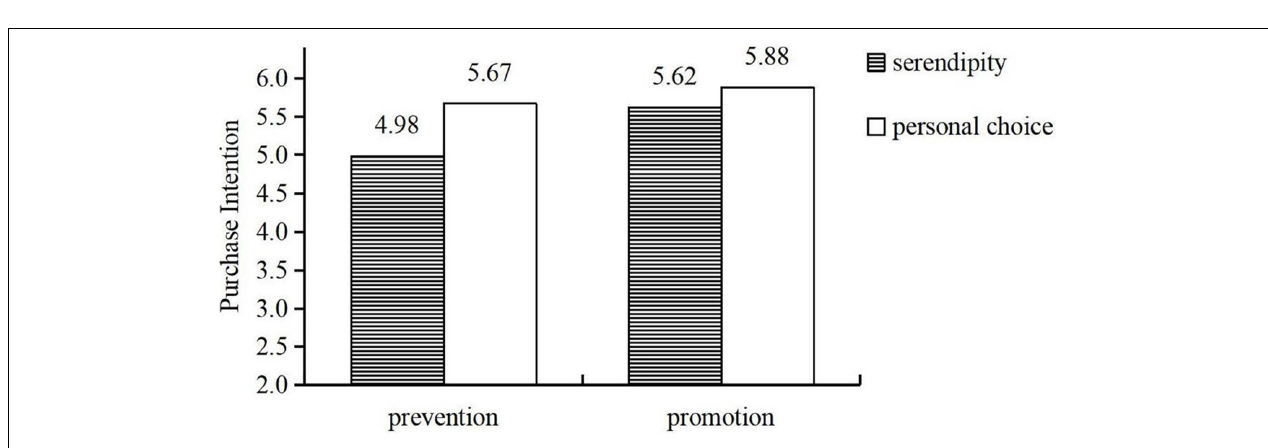
FIGURE 2 | Mediation analysis of perceived risk.